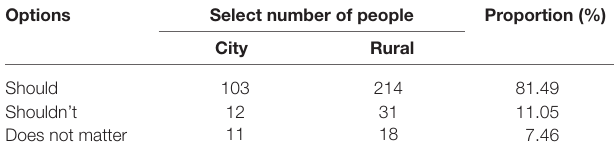
FIGURE 8 | Survey of students’ reasons for receiving discipline in different districts.